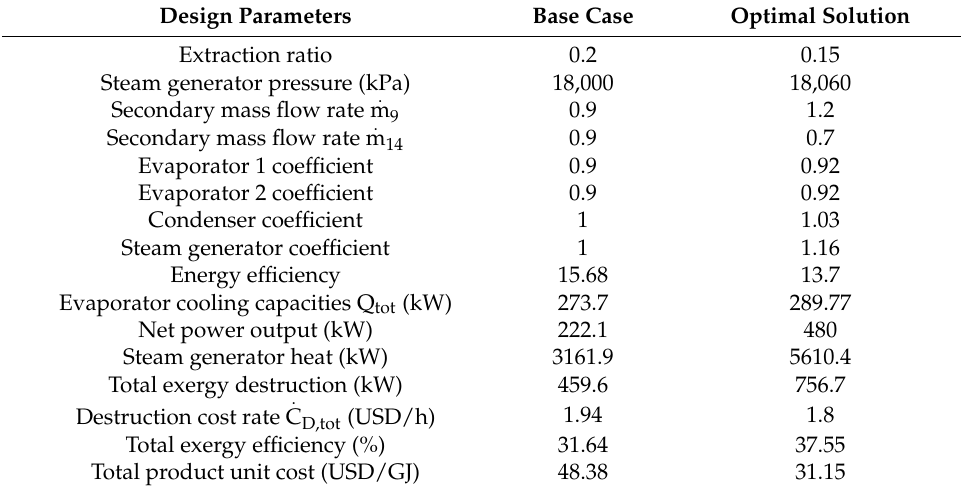
Table 15. Comparison between optimal case and base